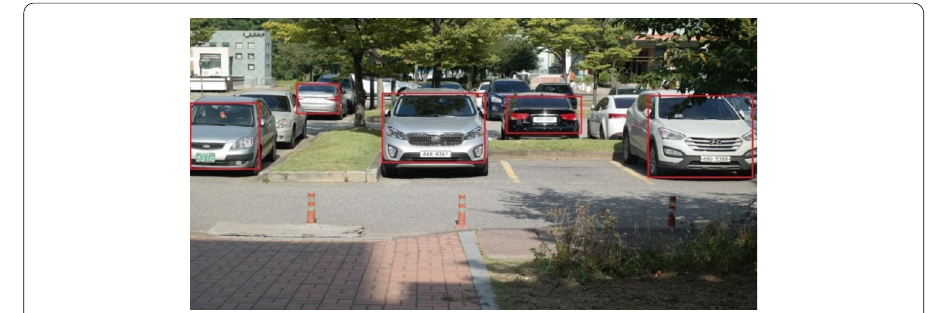
Fig. 3 Test image with vehicle